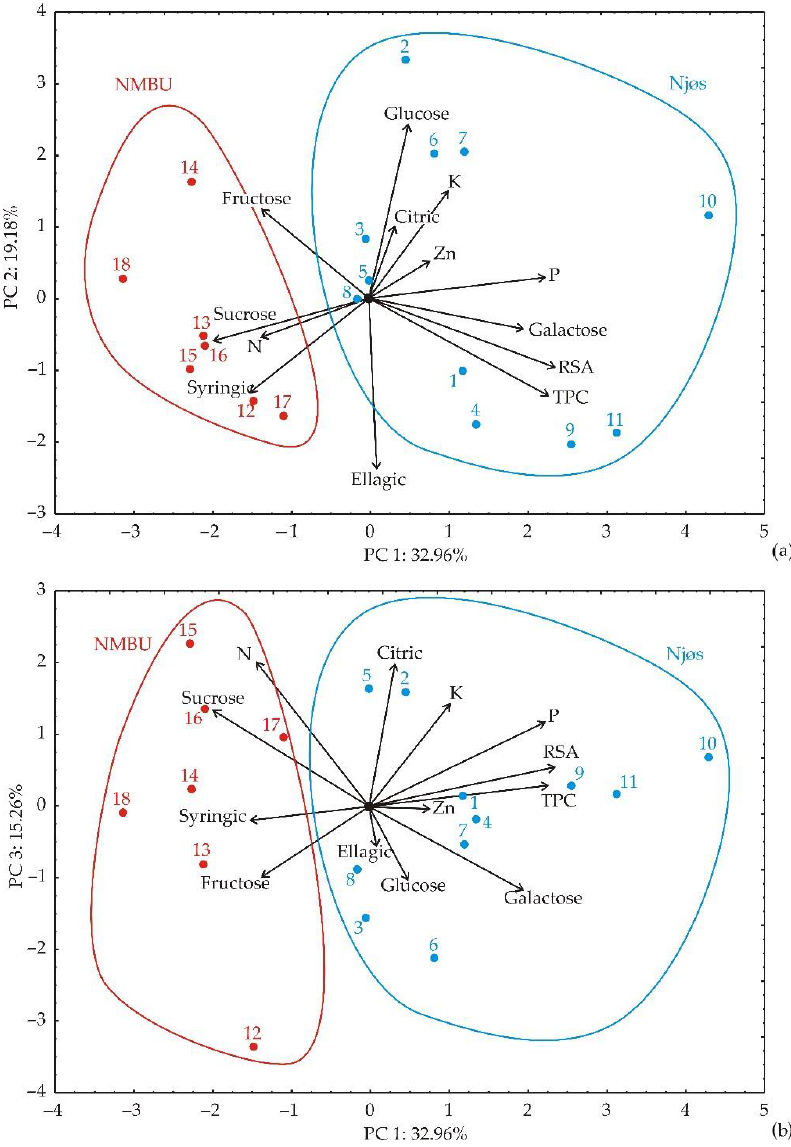
Figure 6. PCA ordination of the most important chemical content variables in raspberry samples in Norwegian regions Njøs and NMBU: ( a ) projection in PC1-PC2 plane; ( b ) projection in PC1-PC3 plane.